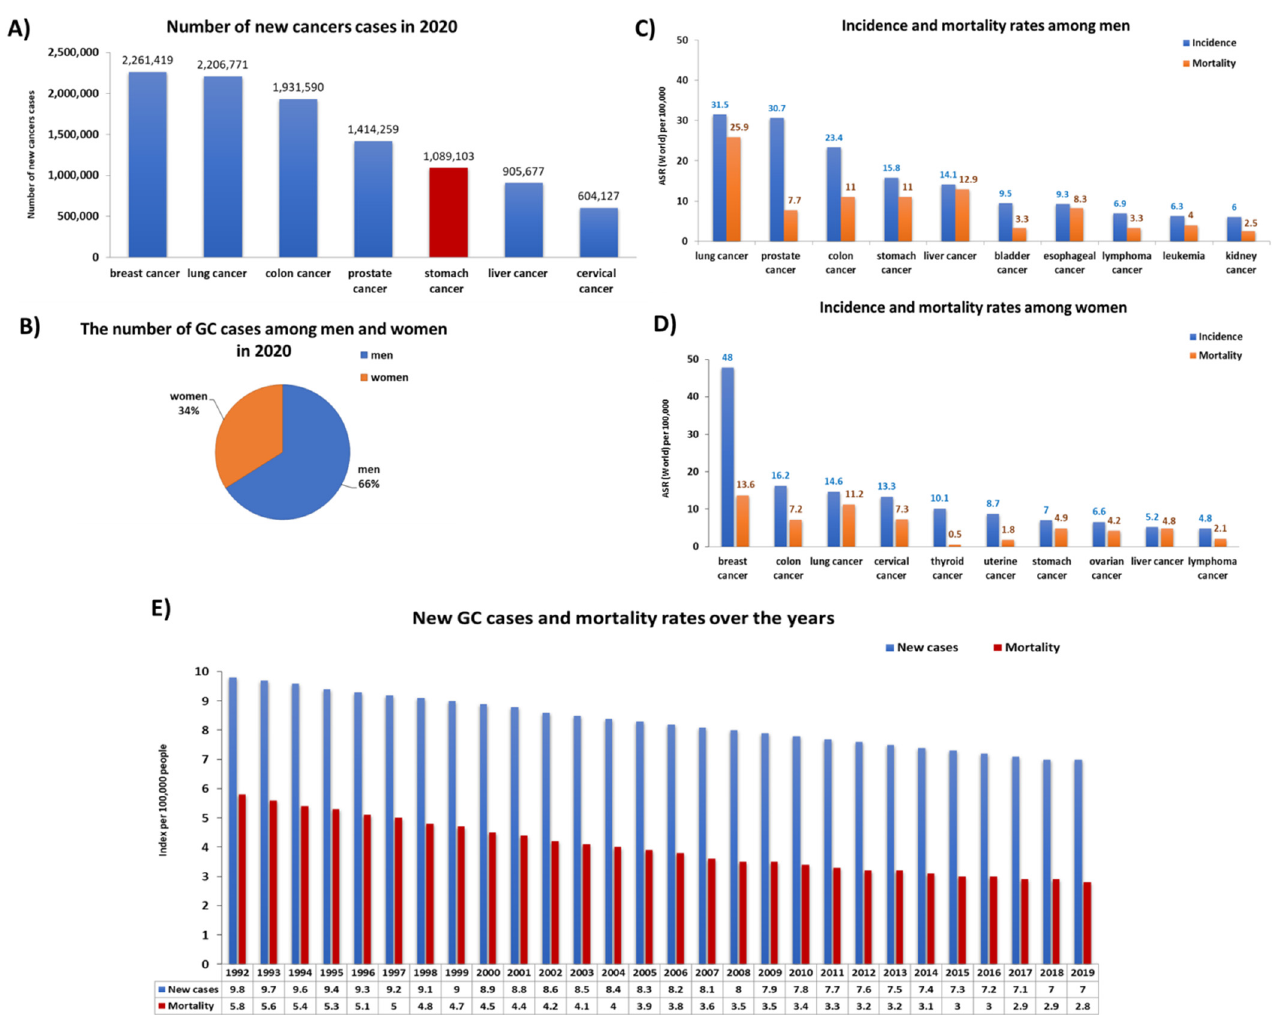
Figure 1. Statistics on the incidence and mortality of gastric cancer (GC) in the world. ( A ) Number of new cases cancer in 2020; ( B ) the number of GC cases among men and women in 2020; ( C ) incidence and mortality rates among men in 2020; ( D ) incidence and mortality rates among men in 2020; ( E ) new gastric cancer cases and mortality rates over the years (base on [4,5]) (ASR—Age-Standard- ized Rate).